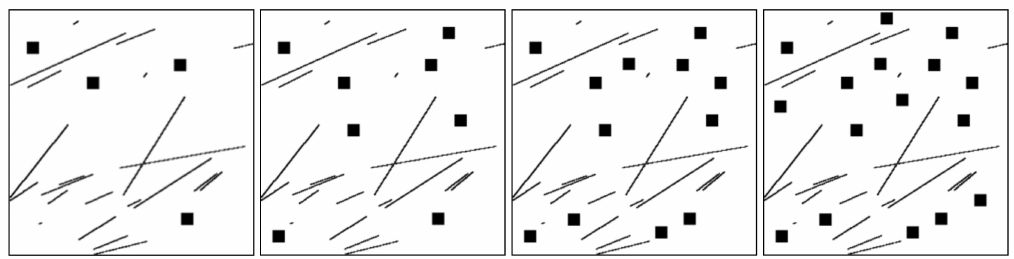
Figure 5. The fracture models with small vugs.